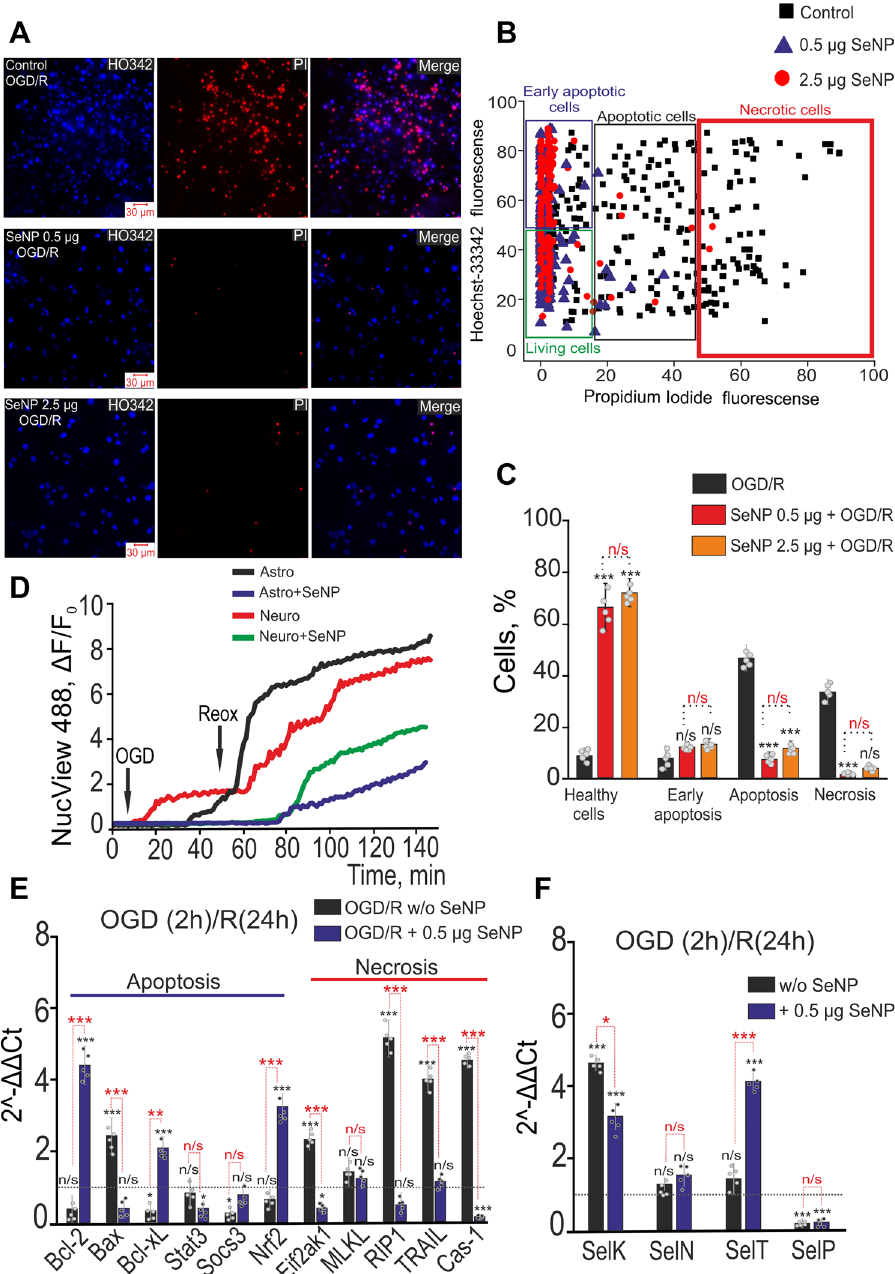
Figure 5. Anti-apoptotic role of SeNPs under OGD and during reoxygenation (R). ( A ) Double staining of cells with Hoechst 33342 (HO342), Propidium iodide (PI) and merge (Merge) between Hoechst342 and PI after 2 h OGD and 24 h reoxygenation (OGD/R) without SeNPs or after 24 h pre-incubation with 0.5 and 2.5 µg/ml SeNPs. ( B ) Cytogram demonstrating the viability of cortical primary cultured neurons and astrocytes. X-axis—the intensity of PI fluorescence; Y-axis—the intensity of Hoechst 33342 fluorescence. Cells were stained with the probes 24 h after the 2 h OGD and 24 h reoxygenation depending on the presence of SeNPs. ( C ) Neuroprotective effects of SeNPs on the induction of necrosis and apoptosis after 2 h OGD and 24 h reoxygenation. The percentage of living cells (black column) and cells in which the processes of early apoptosis (violet column), apoptosis (green column), and necrosis (red column) were detected. Cell cultures were returned to CO 2 -incubator for 24 h after 2 h OGD. Each point represents the mean from an individual cell culture. At least 2000 cells were analyzed for each sample. N cell cultures = 5; n coverslips with cells for each sample = 15. ( D ) Hydrolysis of the fluorogenic substrate of caspase-3 (NucView-488) during a 40-min OGD treatment and the 90 min of reoxygenation, indicating apoptosis induction in neurons and astrocytes of cerebral cortex in the presence and absence of 0.5 µg/ml SeNPs. ( E , F ) Effect of 24-h incubation of cortical cells with 0.5 µg/ml SeNPs on expression of genes involved in regulation of apoptosis and necrosis ( E ), and encoding of selenoproteins ( F ) after 2 h OGD and 24 h reoxygenation. Dashed line—level of gene expression in controls (with 0.5 µg/ml SeNPs, but without OGD/R). The number of samples is 5 (cell cultures number = 5). Statistical significance was assessed using one-way ANOVA followed by the Tukey–Kramer test. n/s—data not significant ( p > 0.05), * P < 0.05, ** P < 0.01, and *** P <